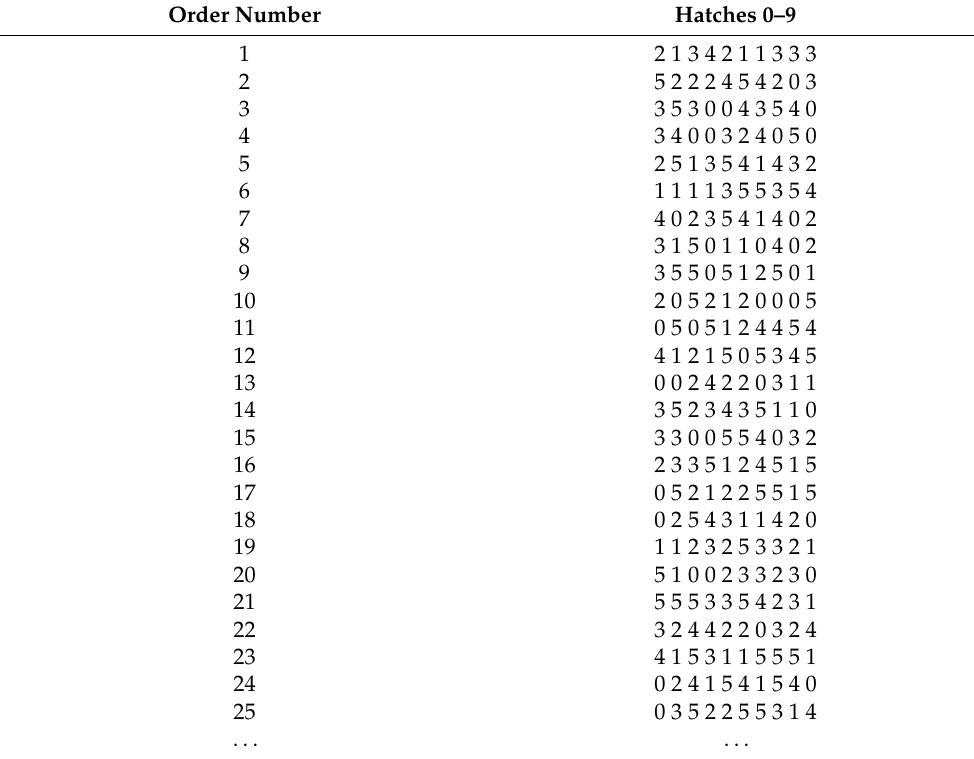
Table 3. Order number for training. Order